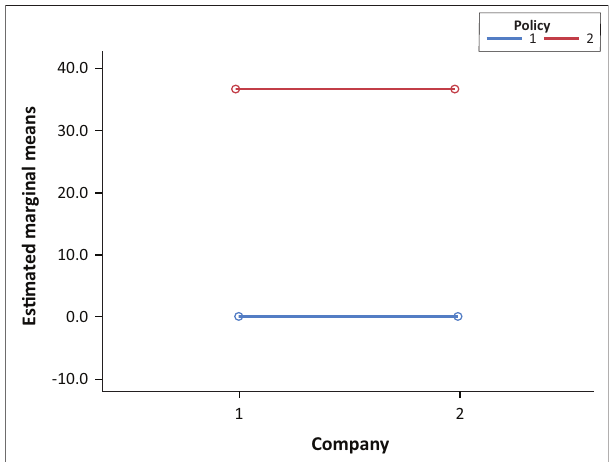
FIGURE 2: Estimated marginal means of D means for companies A and B (as labelled by 1 and 2,